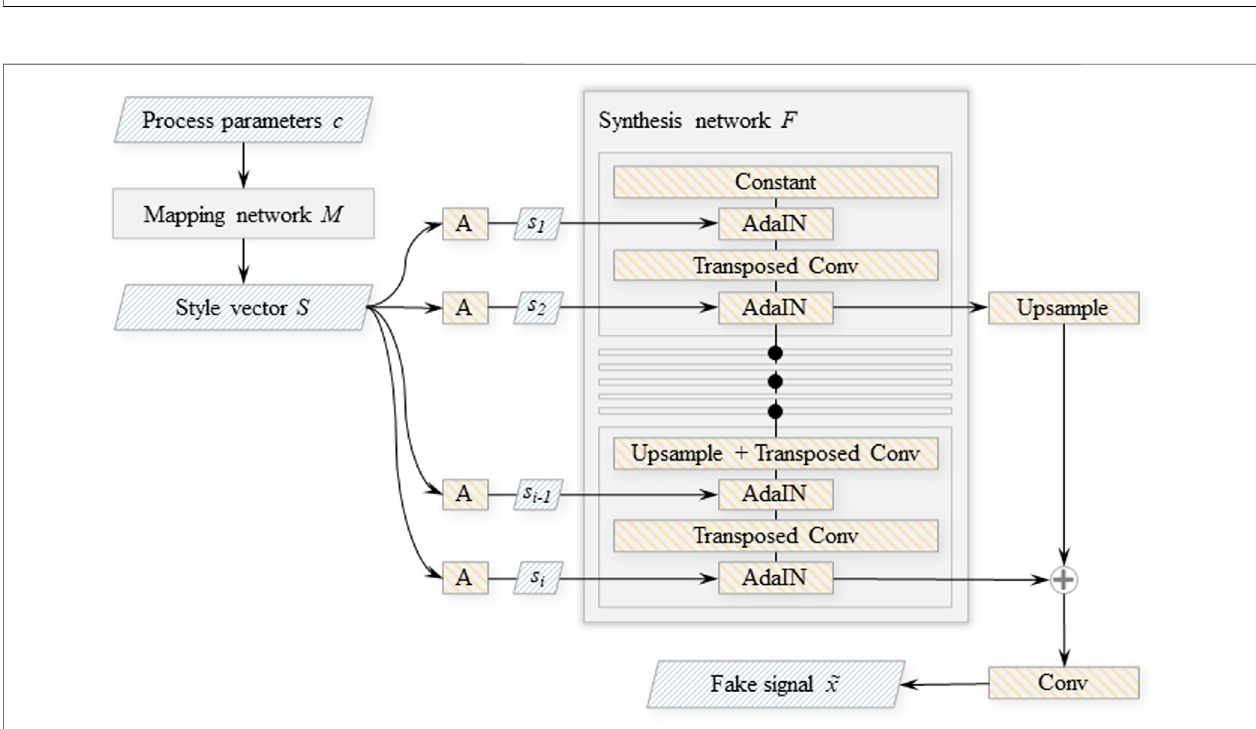
FIGURE 4 | Architecture of the StyleGAN generator network. “ A ″ denotes learned af fi ne transformations of style components s i ; “ AdaIN ”— adaptive instance normalisation (Huang and Belongie, 2017), outputs of which are modulated by the transformed style